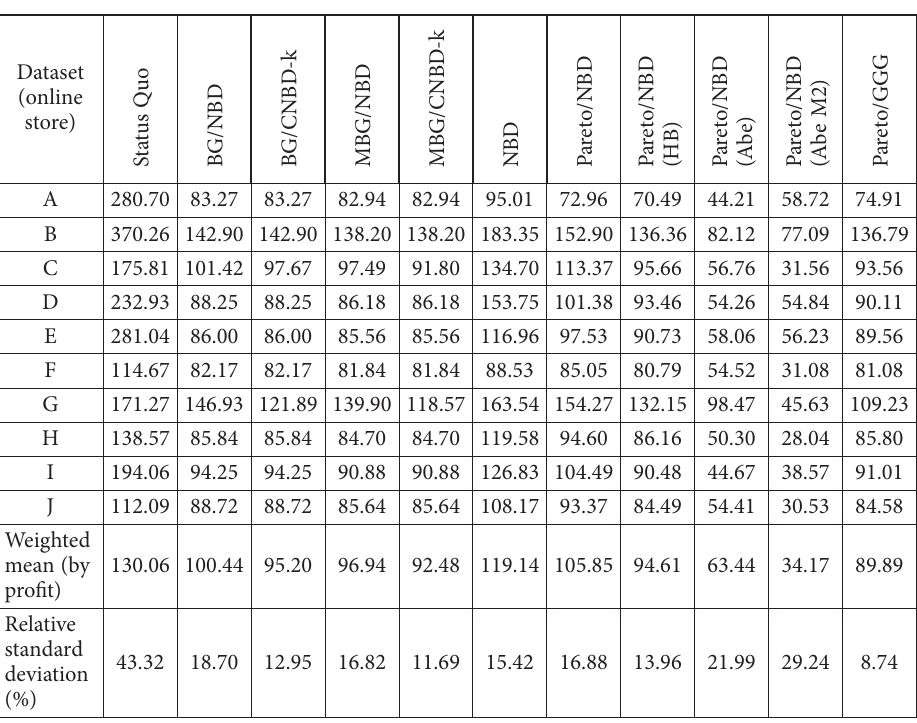
Table 3. Results for Forecast vs. Actual (in